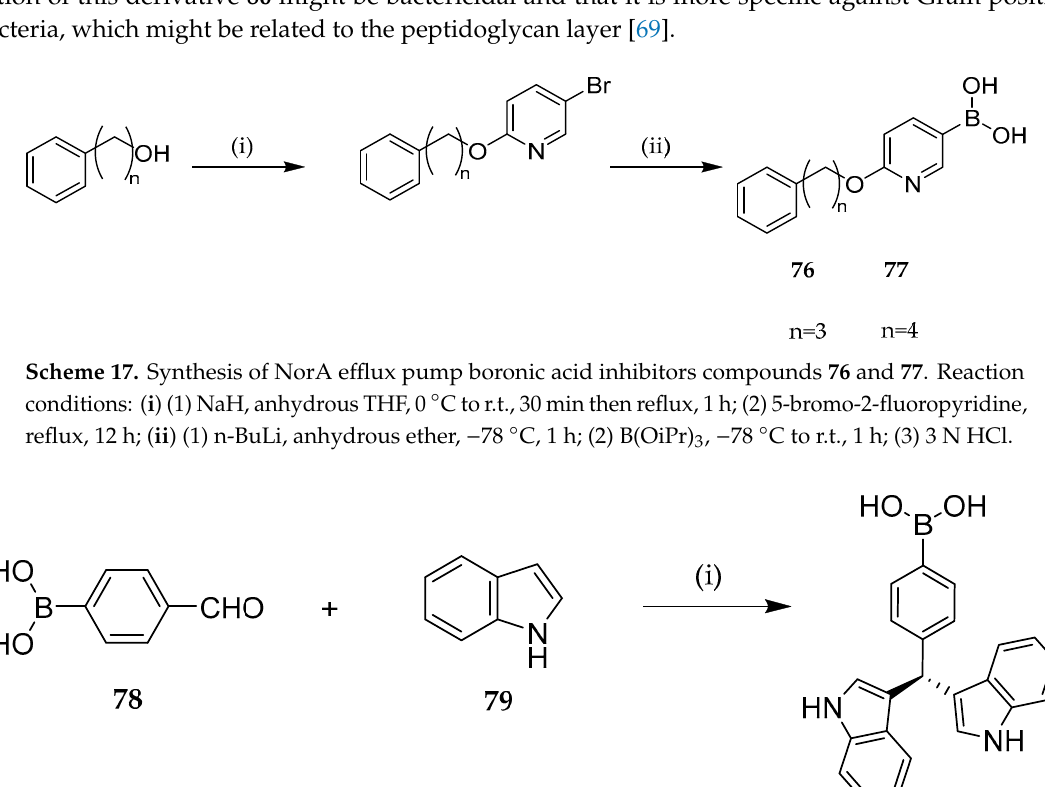
Table 6. Minimum modulatory concentration (MMC, μ g/mL) of ciprofloxacin and norfloxacin when alone or combined with compounds 76 or 77 .